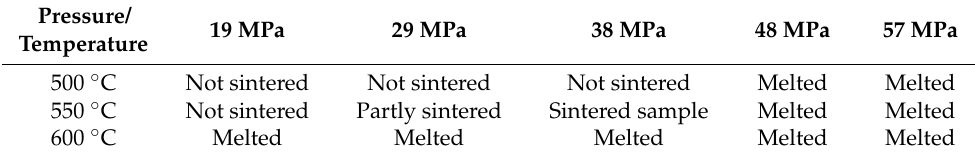
Table 2. Different conditions of spark plasma sintering method.